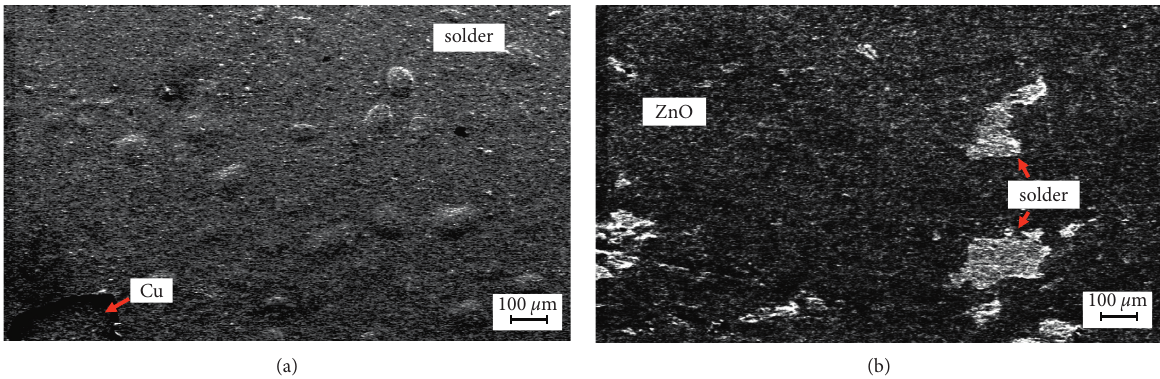
Figure 10: Fractography of a ZnO/Cu joint with Sn